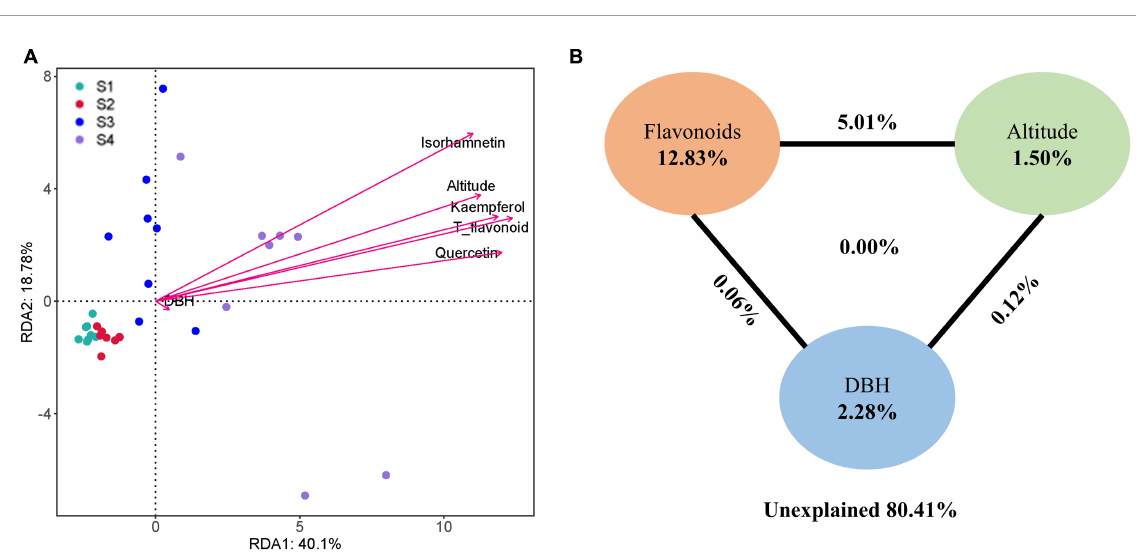
phenylpropanoid biosynthesis and flavonoid biosynthesis) gradually reduced ( p < 0.05). The relative abundance of function genes of photosynthesis in S1 decreased by two-thirds compared with that in S1 ( Figure 6B